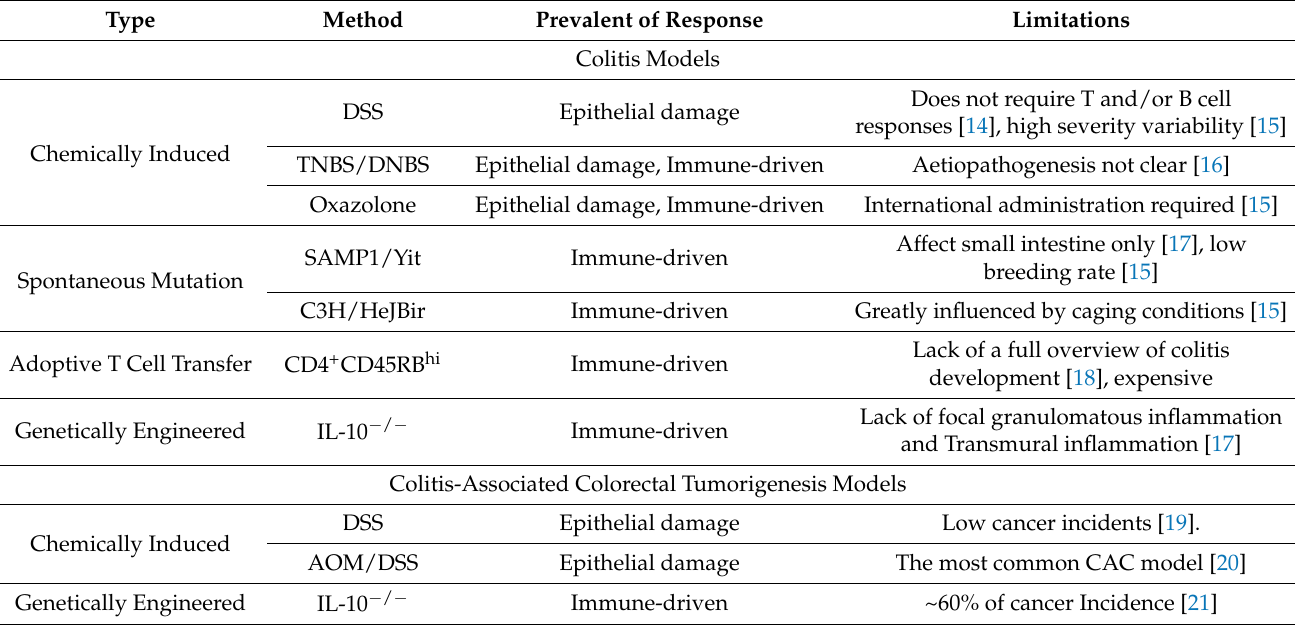
Table 1. The most commonly used animal models in colitis and colitis-associated colorectal tumorigenesis.